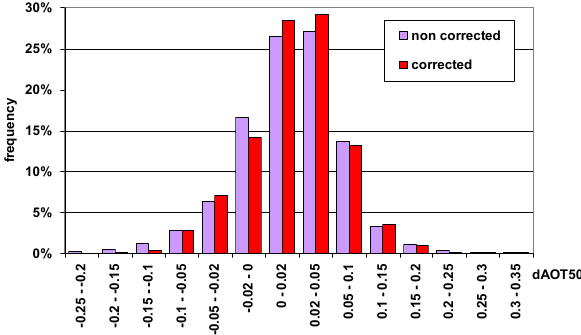
Fig. 5. Frequency distribution of difference in AOT500 with the Fig.5. Frequency distribution of difference in AOT500 with the correction on the air transport correction on the air transport lag and without lag and without it.